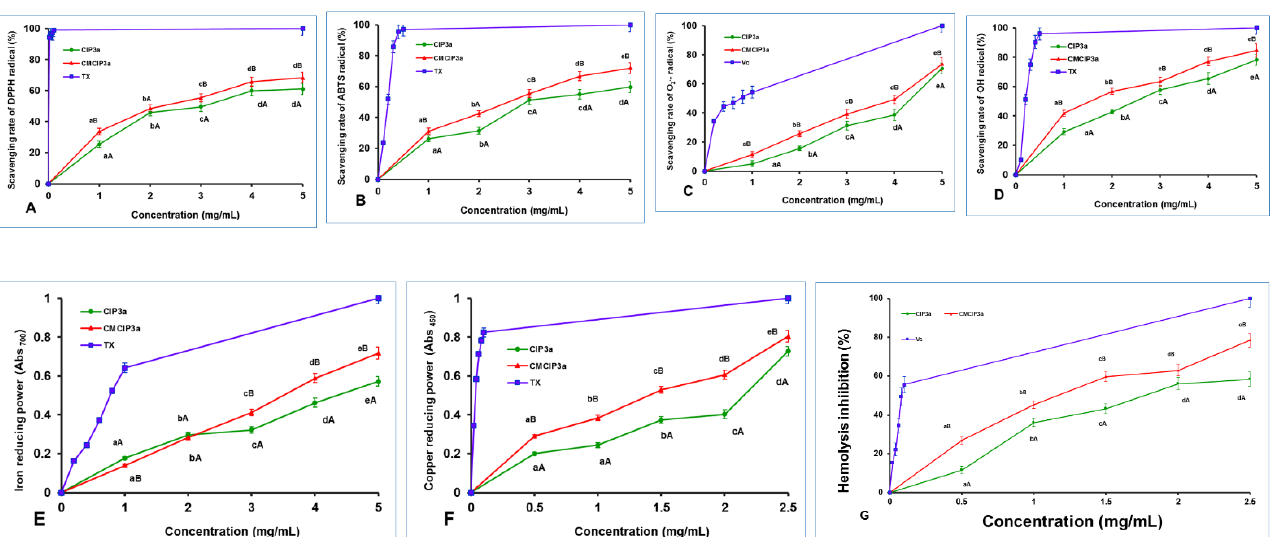
11 of 19 Figure 6. Effect of polysaccharide on the absorbance of Congo red. 3.11. Antioxidant Activity of CIP3a and CMCIP3a Antioxidant activities can be attributed to a variety of processes and reactions, such as radical scavenging activity, binding of transition metal ion catalysts and chain initiation prevention. In the current study, the antioxidant properties of CIP3a and CMCIP3a were assessed in terms of DPPH, ABTS, superoxide, hydroxyl radical scavenging activity, iron